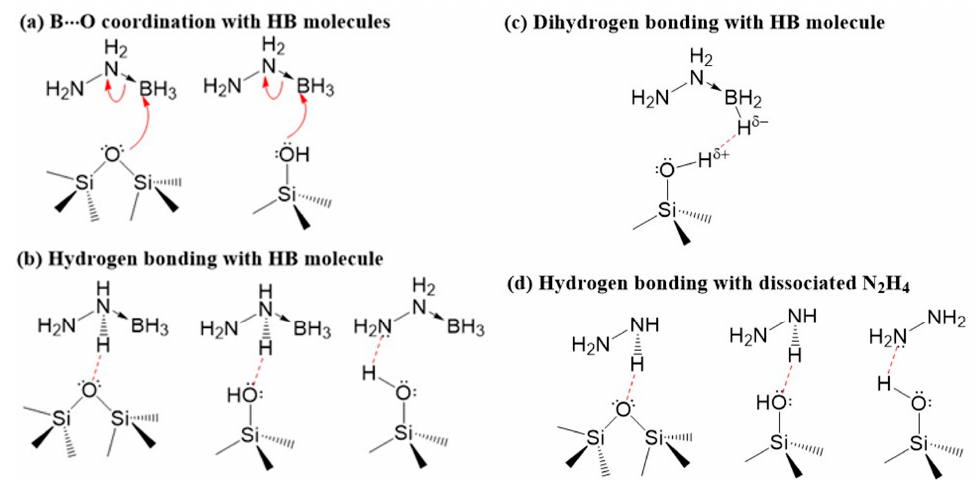
Figure 9. The possible interactions of HB molecules ( a – c ) and dissociated N 2 H 4 ( d ) with surface functional groups (Si-O-Si and Si-OH) in MCM-41 and silica aerogel, respectively.